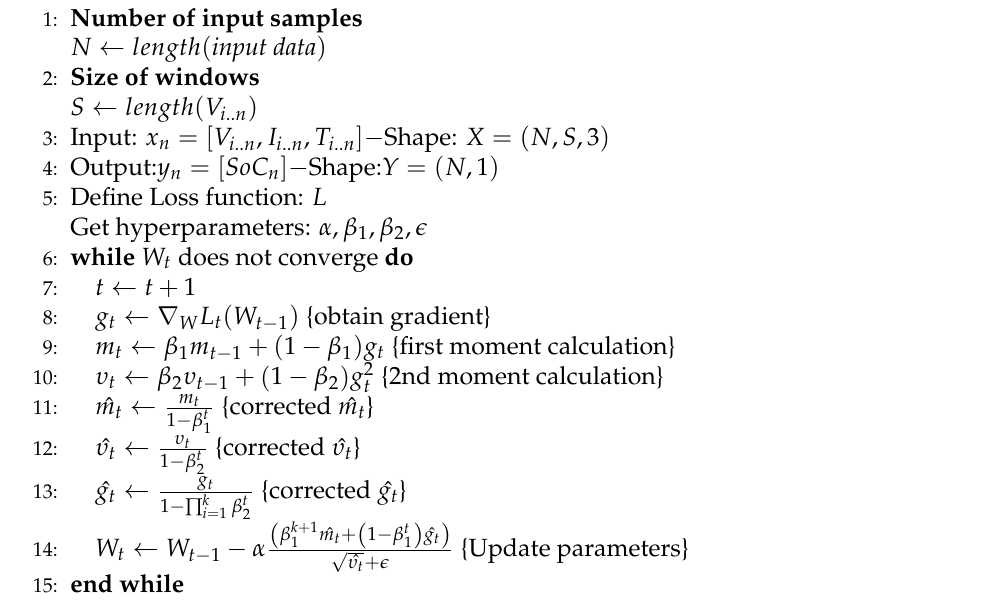
Algorithm 4 Nesterov’s adaptive moment estimation (Nadam) optimisation.